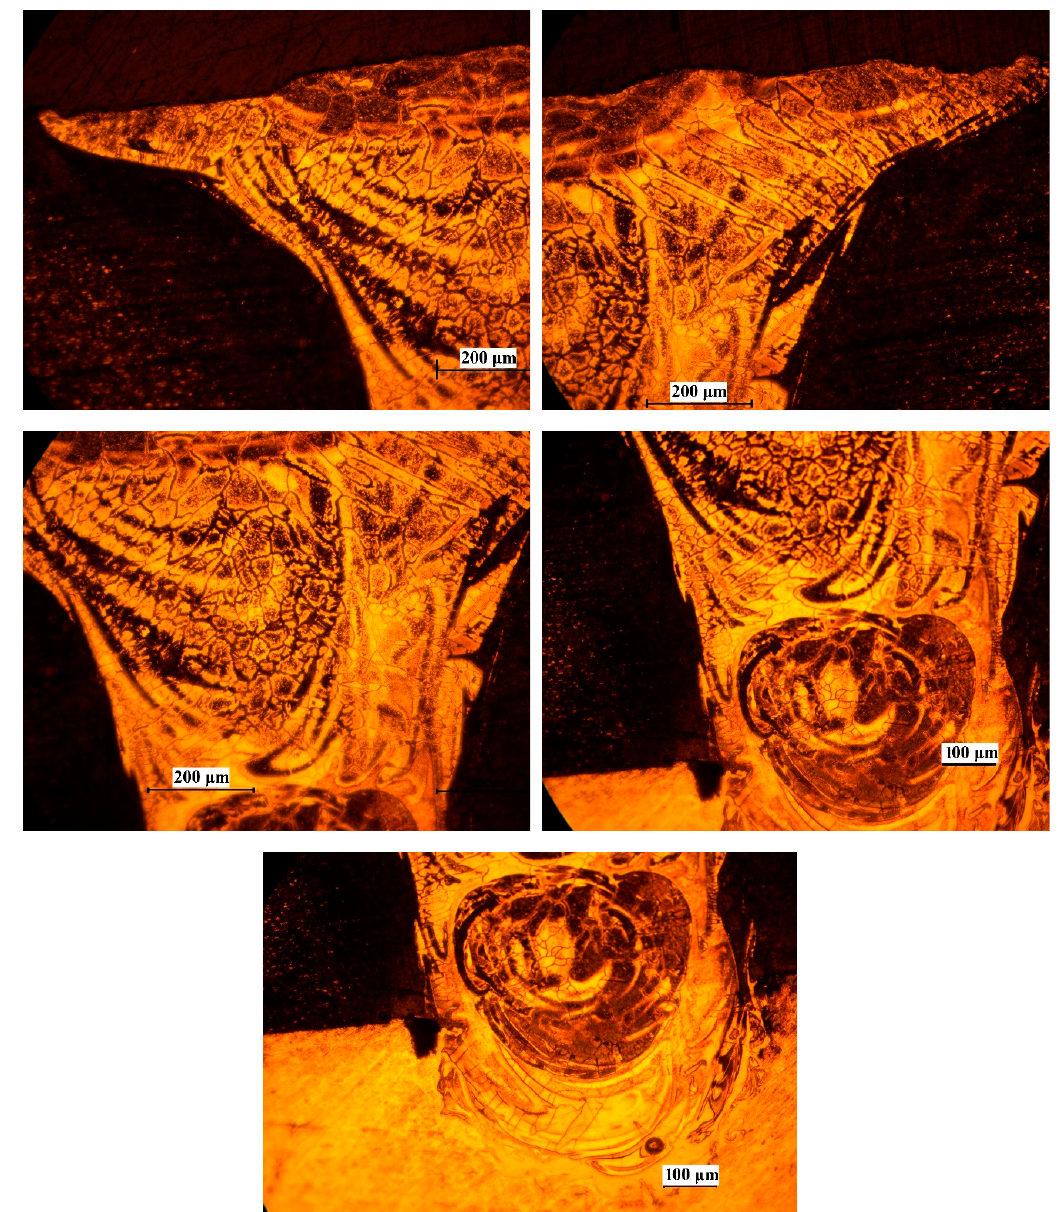
Figure 13. Optical microscope observations of the welded zone.